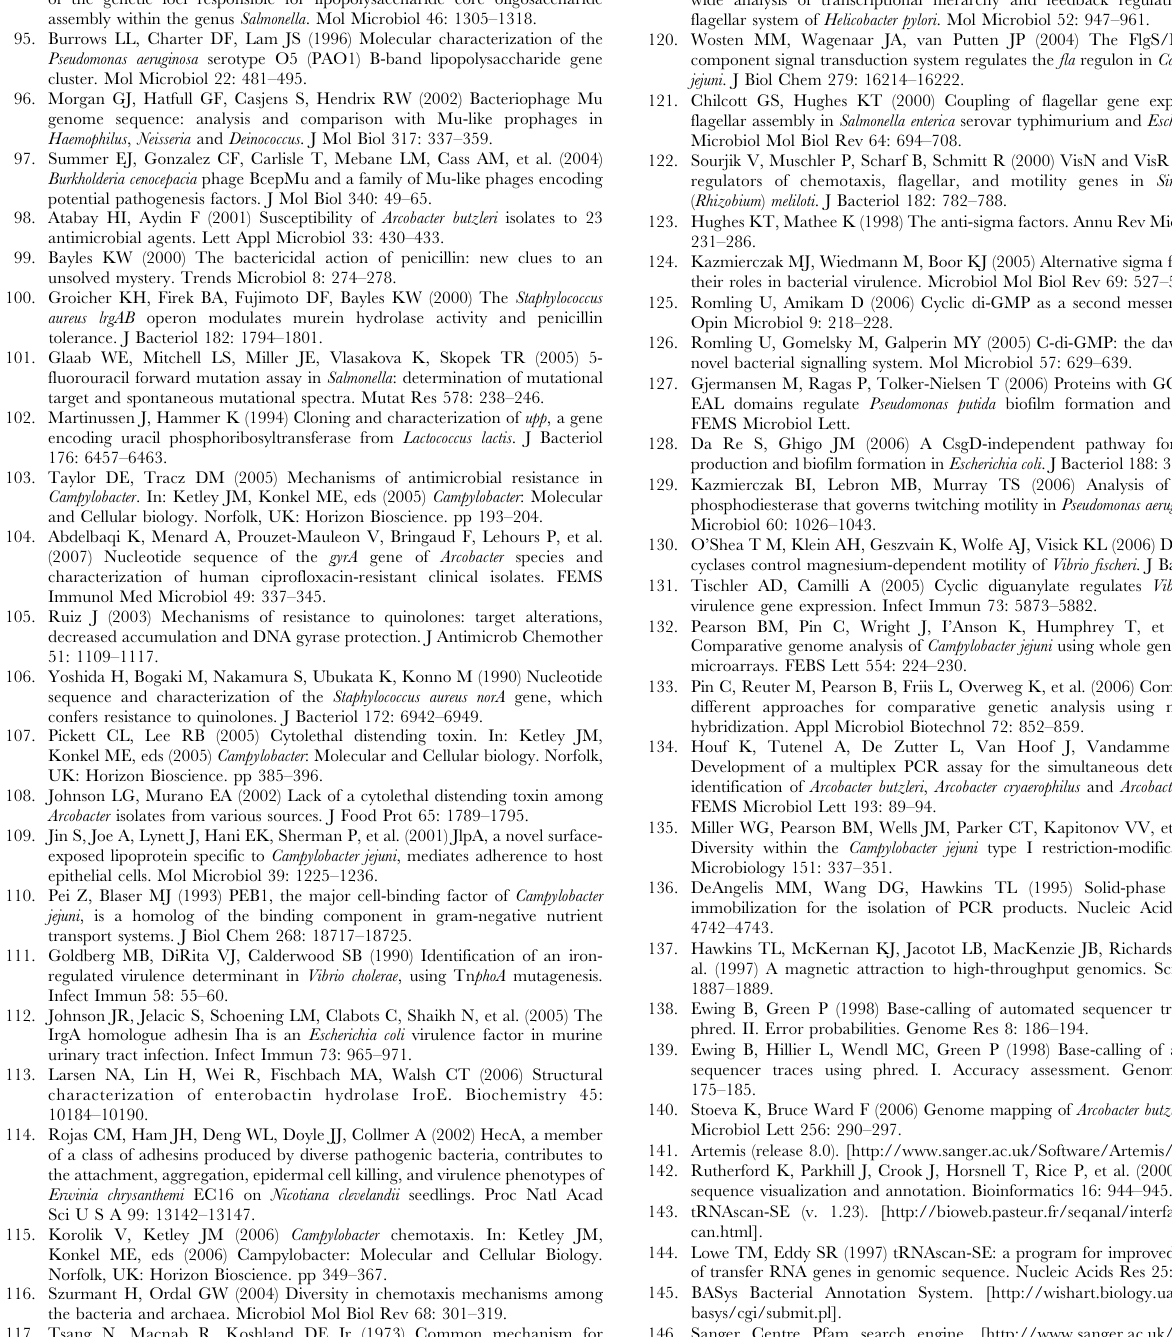
147. Zoomable Arcobacter butzleri strain RM4018 BLAST atlas. [http:// www.cbs.dtu.dk/services/GenomeAtlas/suppl/zoomatlas/?zpid=Arcobac-